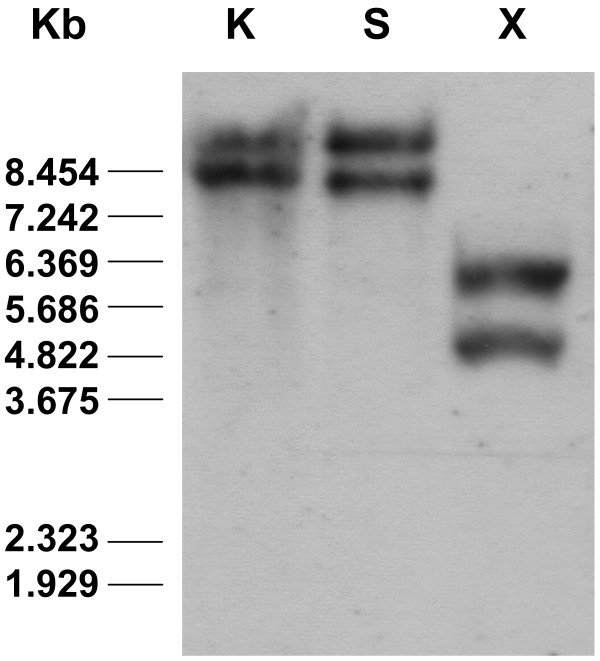
Southern blot analysis of Vitis vinifera genomic DNA to evaluate the genomic organisation of Vv-AMP1. Vitis vinifera cv. Pinotage genomic DNA was digested with KpnI (K), SpeI (S) or XbaI (X) and probed with a DIG labeled cDNA copy of Vv-AMP1. Lambda DNA digested with BstEII was used as marker (sizes indicated). Each signal indicates a single copy of Vv-AMP1.